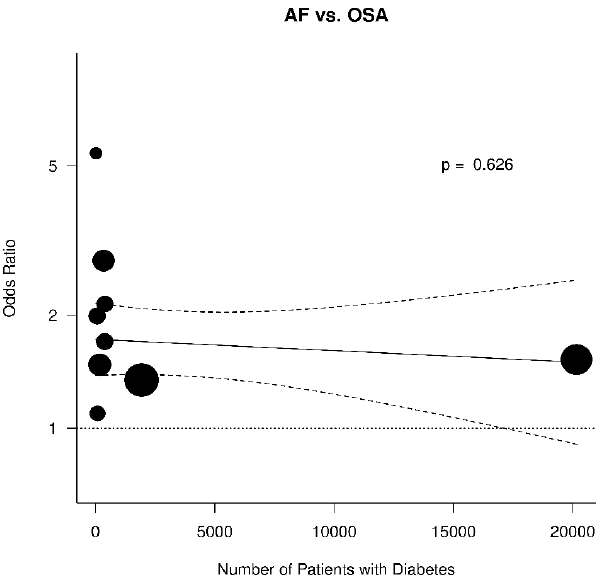
Figure 7. Effect of hypertension in the odds ratio for atrial fibrillation (AF) in patients with obstructive sleep apnea (OSA).